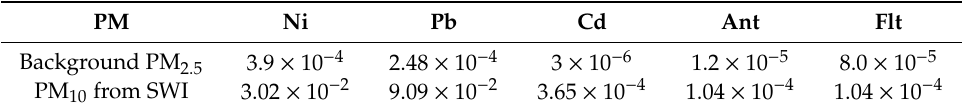
Figure 6. Background PM 2.5 chemical speciation; mass of the contaminant in PM over the PM total mass. Flt = Fluoranthene, Ant = Anthracene, Cd = Cadmium, Pb = Lead, Ni = Nickel. Table 3. Ratio between the mass of the contaminant in PM over the PM total mass. Ni = Nickel, Cd = Cadmium, Pb = Lead, Ant = Anthracene, Flt = Fluoranthene. PM Ni